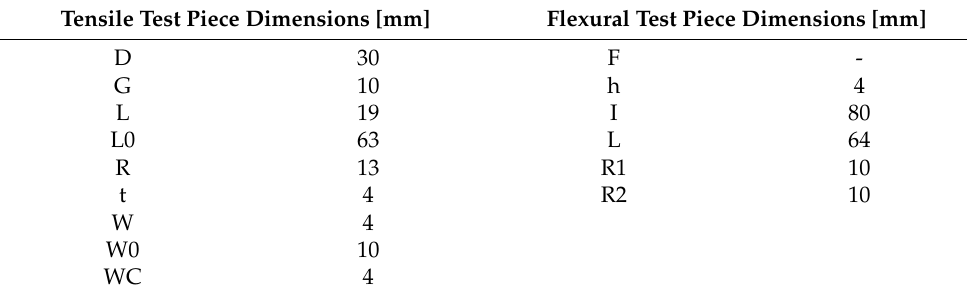
Figure 1. ( a ) Tensile specimen geometry (based on ASTM D638.14) and ( b ) Flexural specimen ge- ometry (based on ISO 14125). Table 3. Tensile and flexural specimen dimensions. Table 3. Tensile and flexural specimen dimensions.